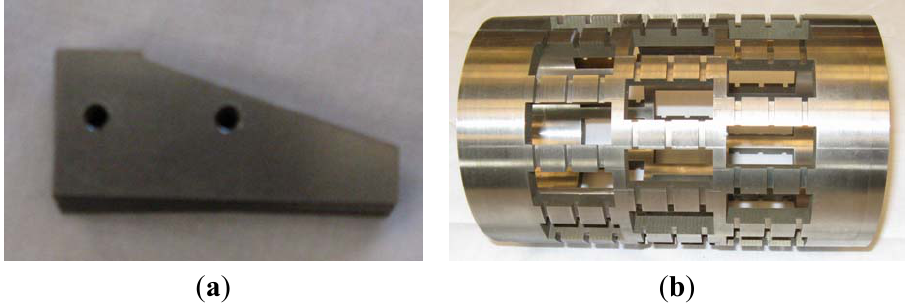
Figure 11. Components of the claw-pole rotor: ( a ) the claws; ( b ) the non-magnetic